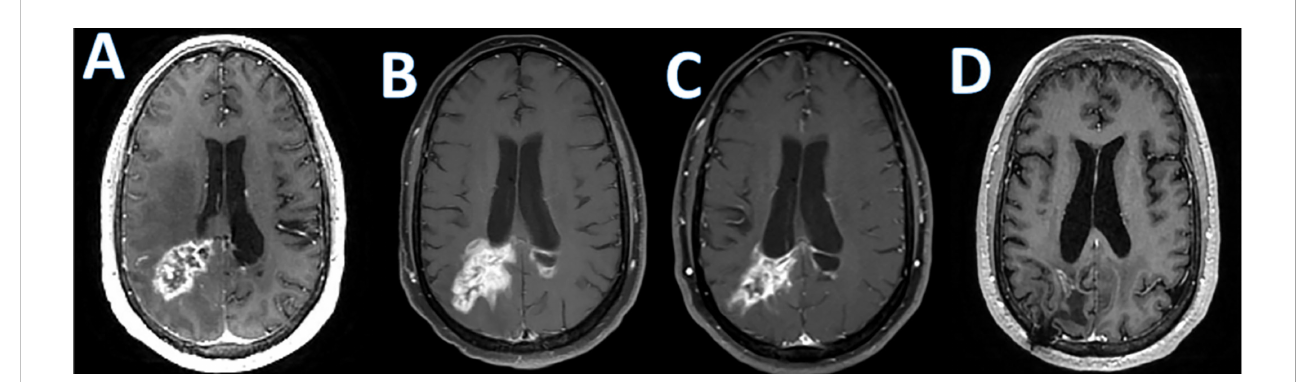
FIGURE 1 Checkpoint inhibitor associated pseudoprogression. T1 post-contrast enhanced MRI images in a patient with refractory primary central nervous system lymphoma treated with Pembrolizumab; (A) ; baseline, (B) ; increase in abnormal enhancement consistent with pseudo progression 9 weeks after starting pembrolizumab, (C) ; minor response at 7 months; (D) ; near complete response at 10